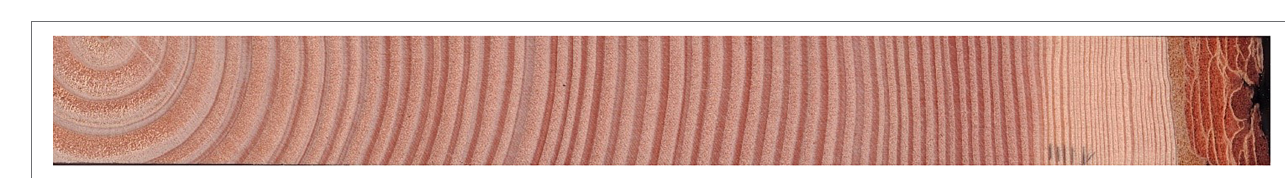
FIGURE 2 | Cross-section of Douglas fir from